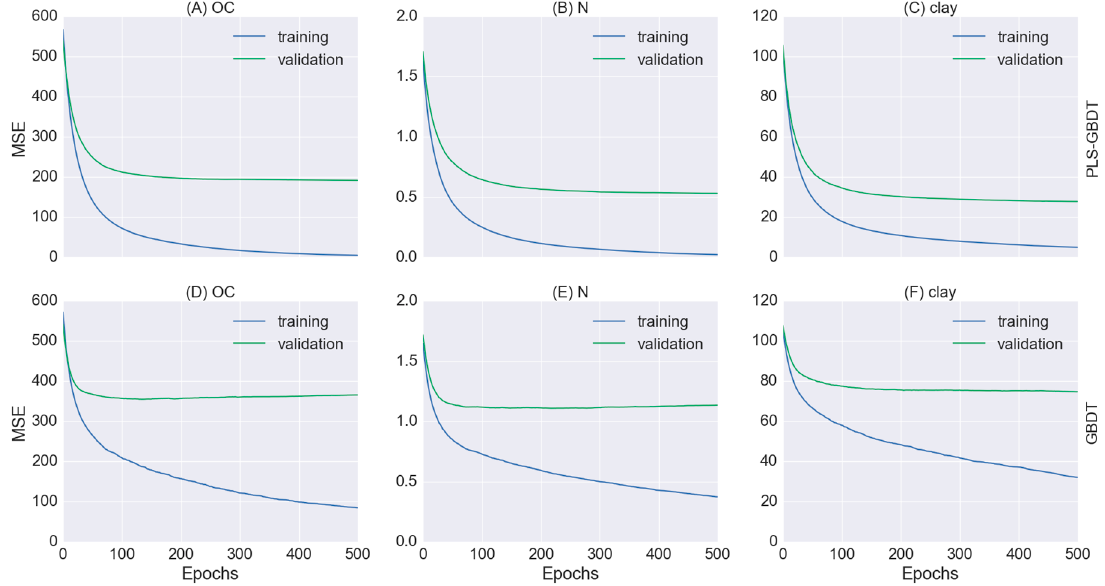
Figure 7. Training and validation curves of soil spectroscopic models developed by PLS-GDBT ( A – C ) and GBDT ( D – F ) in 500 epochs for woodland soil samples.